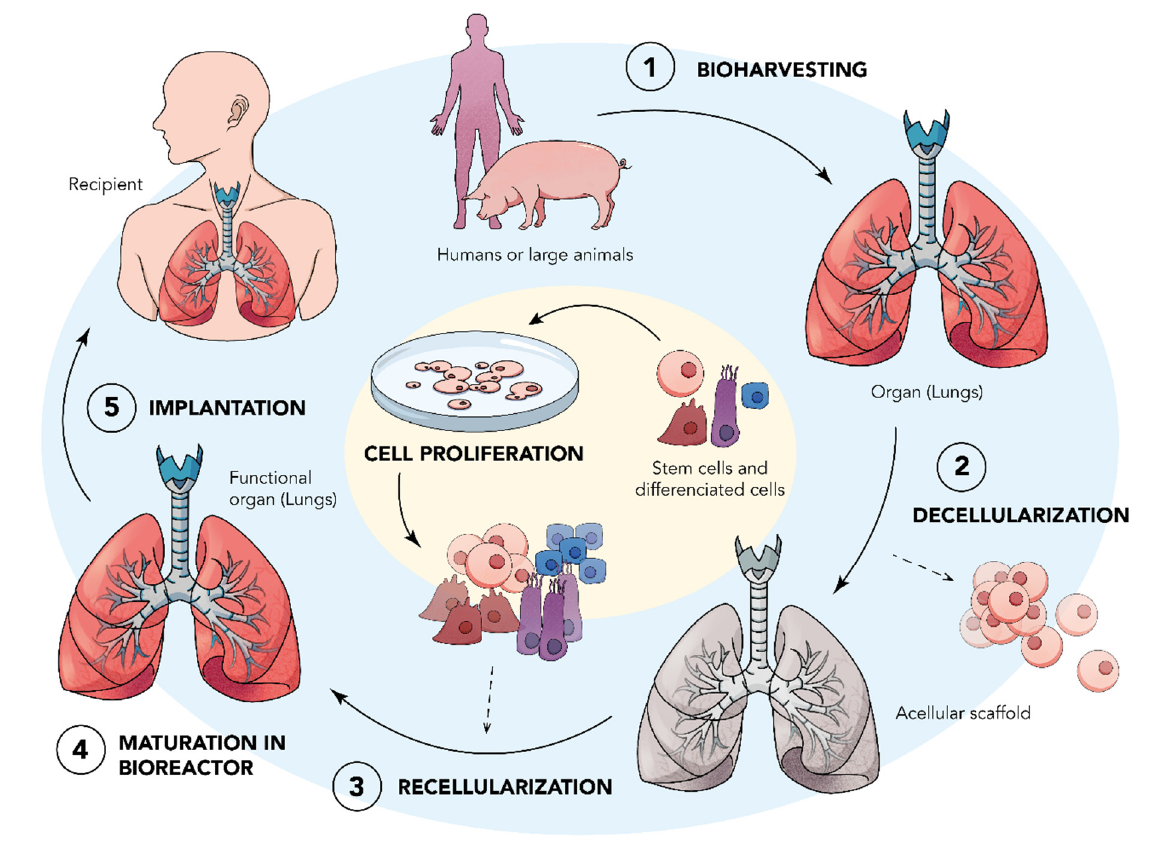
Figure 1. A schematic representation of developing bioengineered lungs.